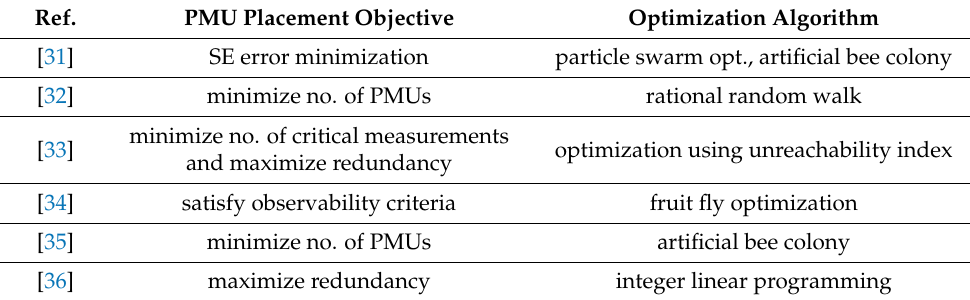
Table 2. Classification of possible DSSE utilization.